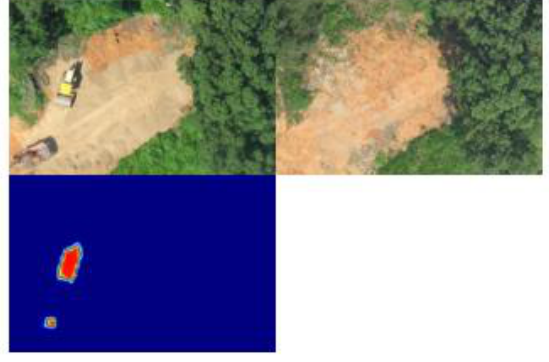
Figure 3. Cases of errors while detecting changes based on general change detection data: ( a ) Con- struction equipment, ( b ) automobile, ( c ) shadow. The left figures are time 1 images, the middle figures are time 2 images, and the right figures show the results obtained using change detection. 2.4. Evaluation Metrics We evaluate our network based on the test data by computing the F -measure, which is calculated using the precision and recall [18]. Recall: Re = T P T P + F N Precision: Pr = T P T P + F P . F -measure: F = 2 P r * R e P r + R e